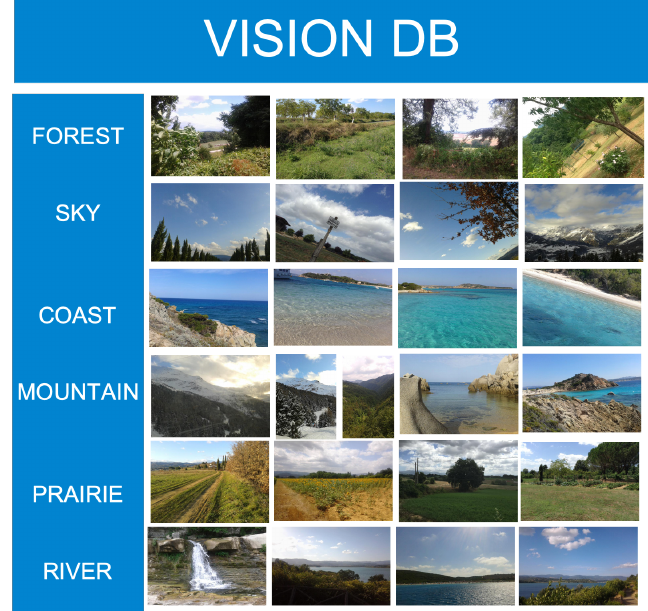
Figure 11. Natural scenes examples from Shullani database [16].